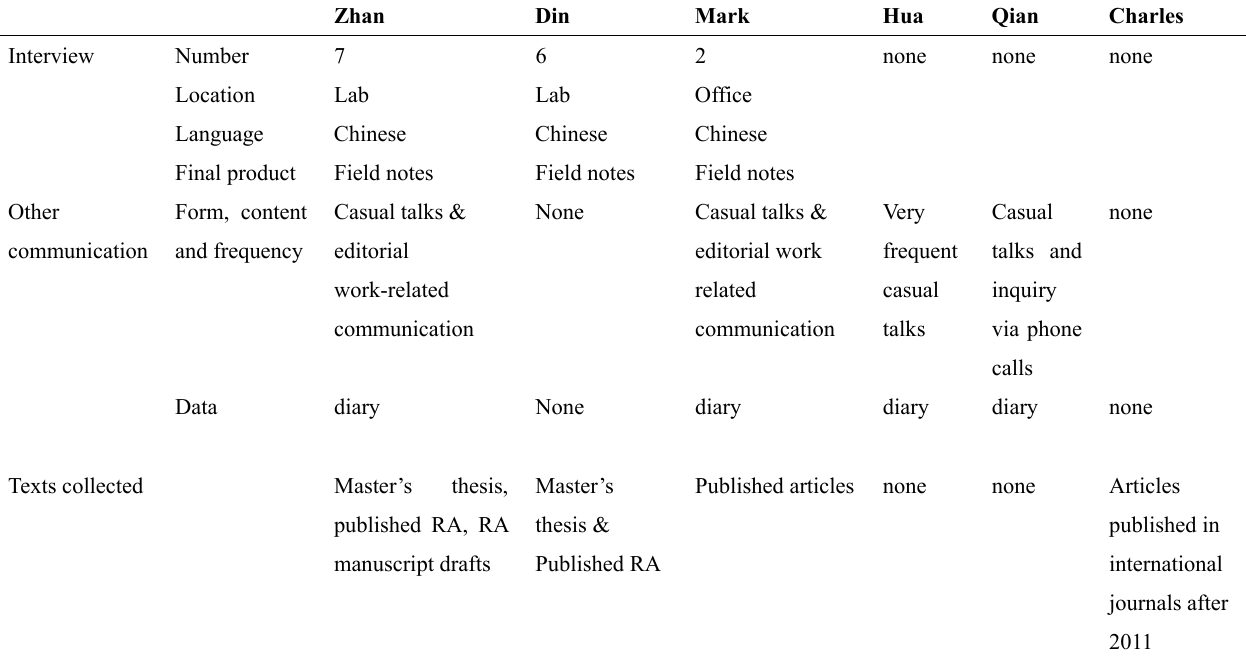
Table 2. Data collection means and